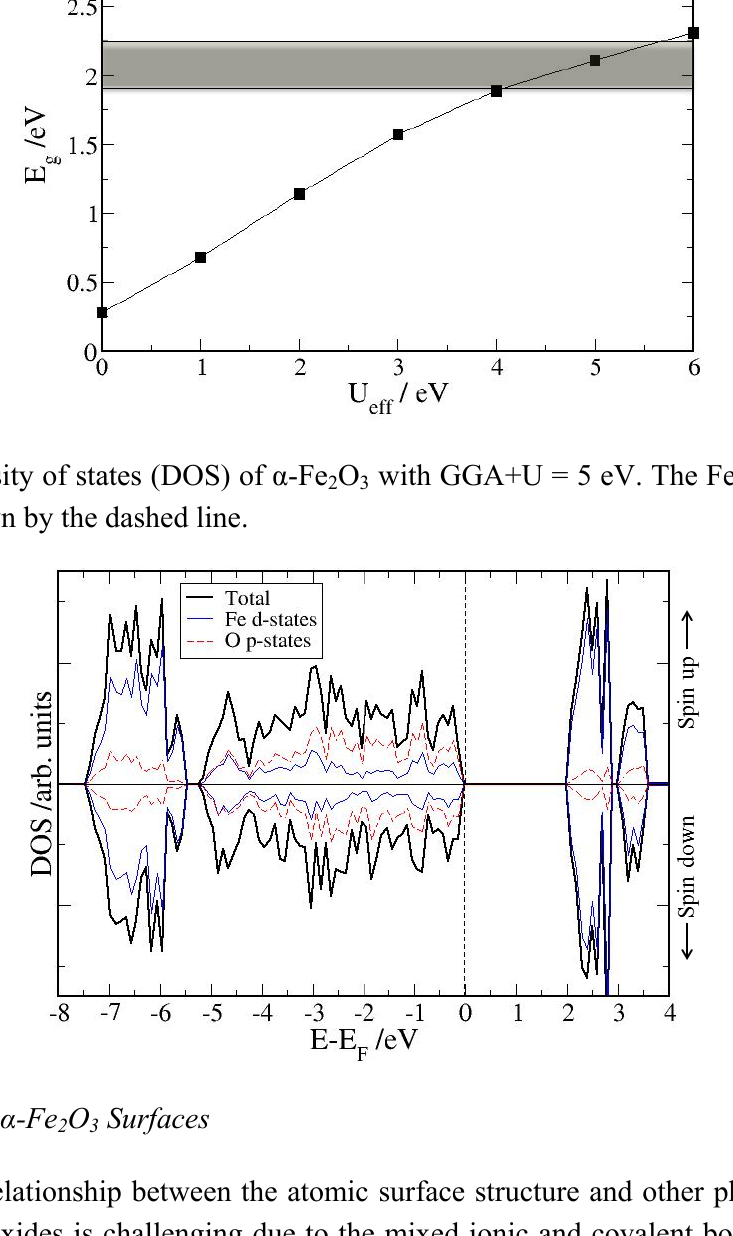
Figure 4. Electronic band-gap for α-Fe experimental band-gap range is indicated by the shaded area.